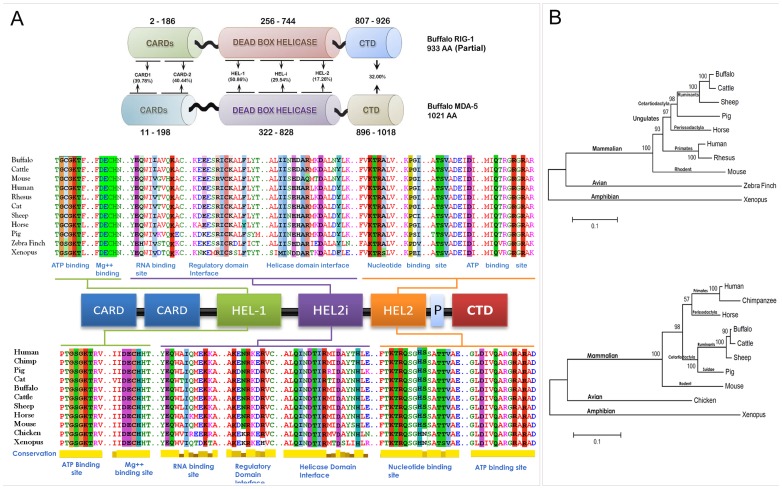
Amino acid sequence analysis of RIG1 and MDA5 receptors.(A) Sequence comparison of functional domains and binding residues of RIG1 and MDA5. Multiple sequence alignment was performed by MAFFT web server and binding site residues (highlighted) were identified by DELTA-BLAST and CDD database of NCBI. (B) The evolutionary history was inferred by using the Maximum Likelihood method of MEGA5 based on the JTT matrix-based model. The trees with the highest log likelihood are shown. Initial tree(s) for the heuristic search were obtained automatically by applying Neighbor-Join and BioNJ algorithms to a matrix of pairwise distances estimated using a JTT model, and then selecting the topology with superior log likelihood value. Sequences used for analysis are provided in Table S2 in File S1.